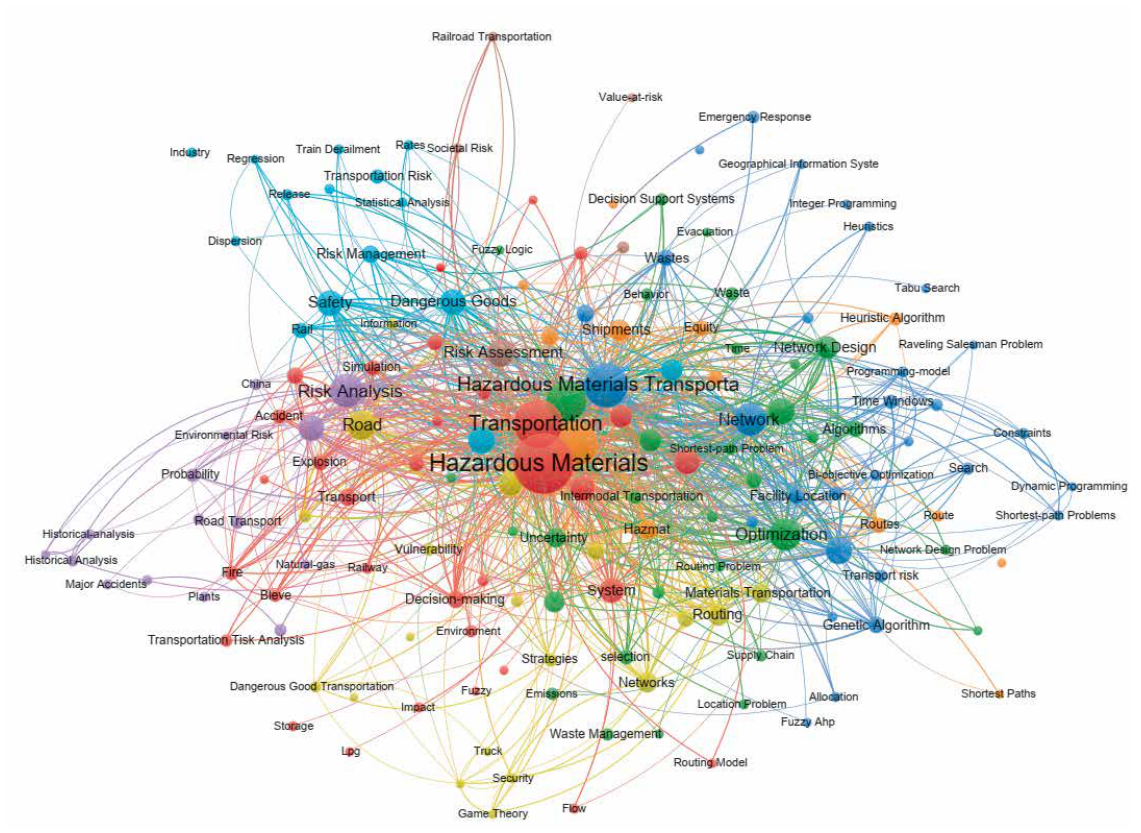
Figure 1: Keyword co-occurrence network of hazardous materials